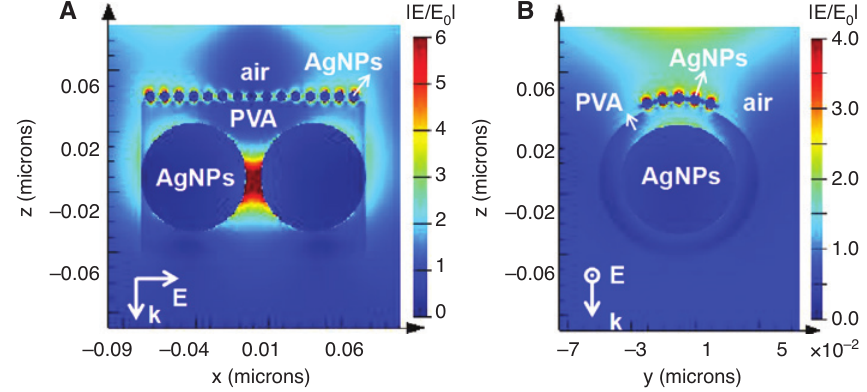
Figure 8: FDTD simulation results of the local electric field distribution. (A) The local electric field distributions for the AgNPs/PVA@Ag nanofibers substrate from (A) x-z cross-section and (B) y-z cross-section. The direction of polarization and incident light is x and negative z direction in all theoretical calculations,